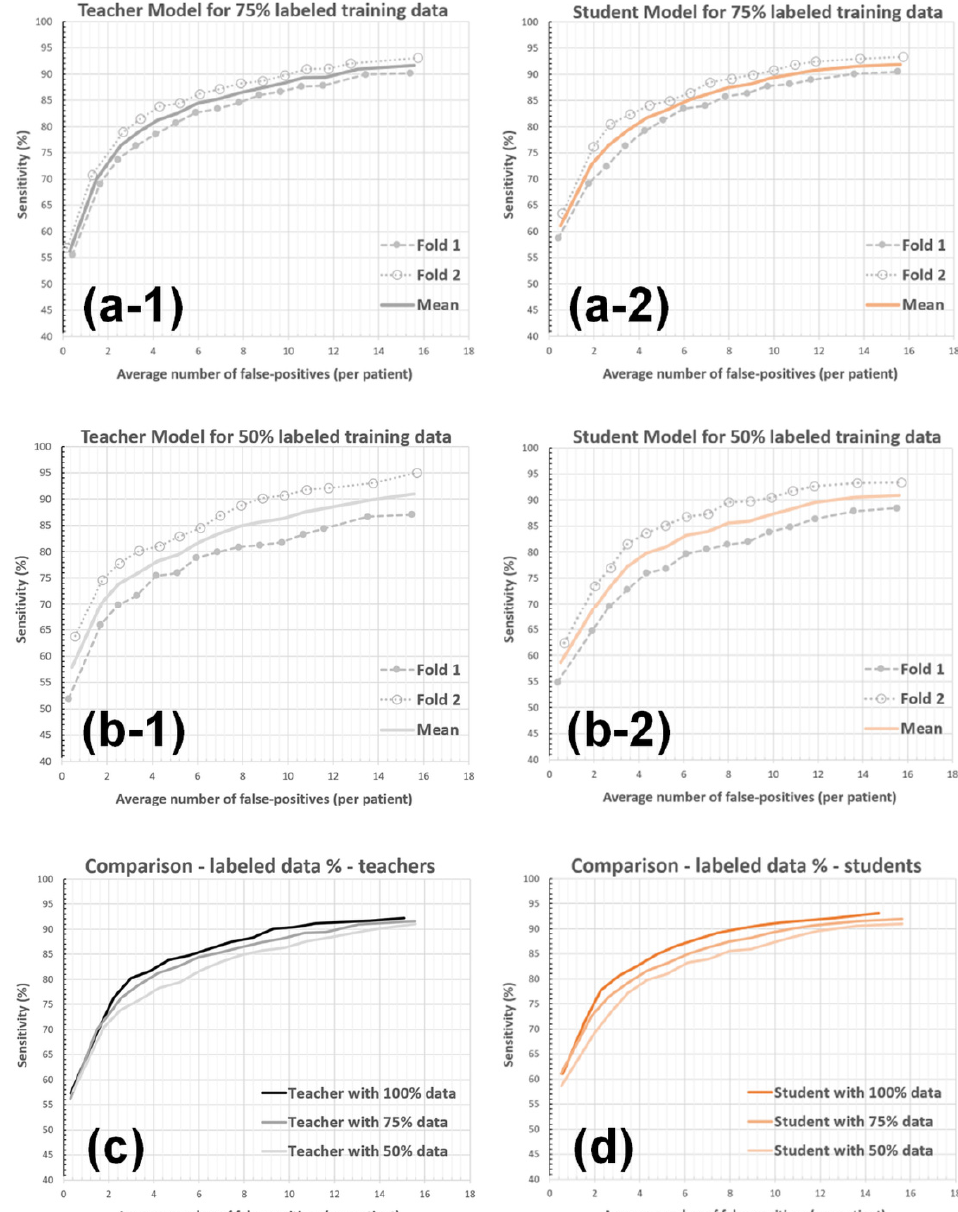
Figure 10. The impact of the amount of labeled data on the AFP metric. The teacher ( a-1 ) and student ( a-2 ) models were trained using 75% of the labeled data. The teacher ( b-1 ) and student ( b-2 ) models were trained using 50% of the labeled data. The teacher ( c ) and student ( d ) models were compared for different labeled-data utilization percentages. Table 5. AFP vs. sensitivity for different amount of labeled-data (LD) utilization percentages.